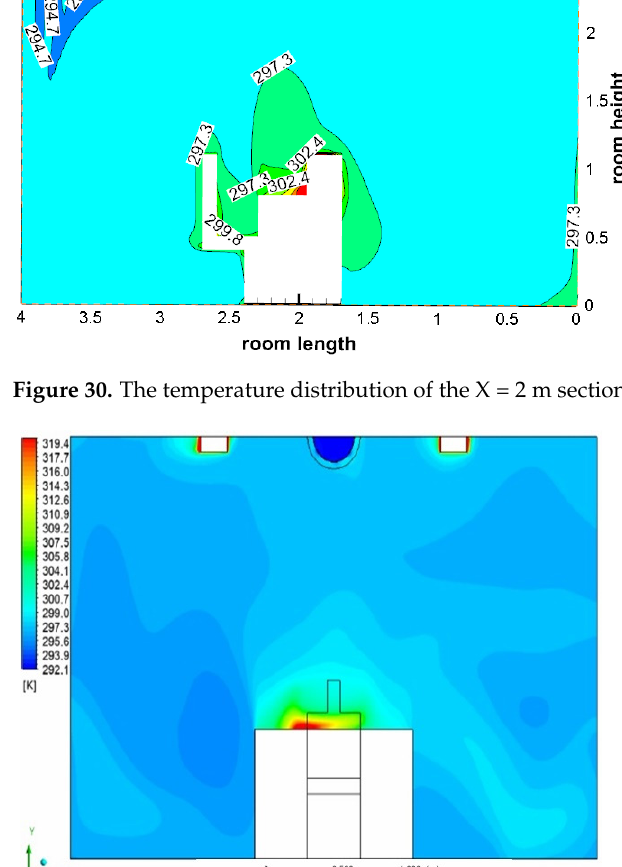
Figure 31. The temperature distribution of the Z = 2 m section.